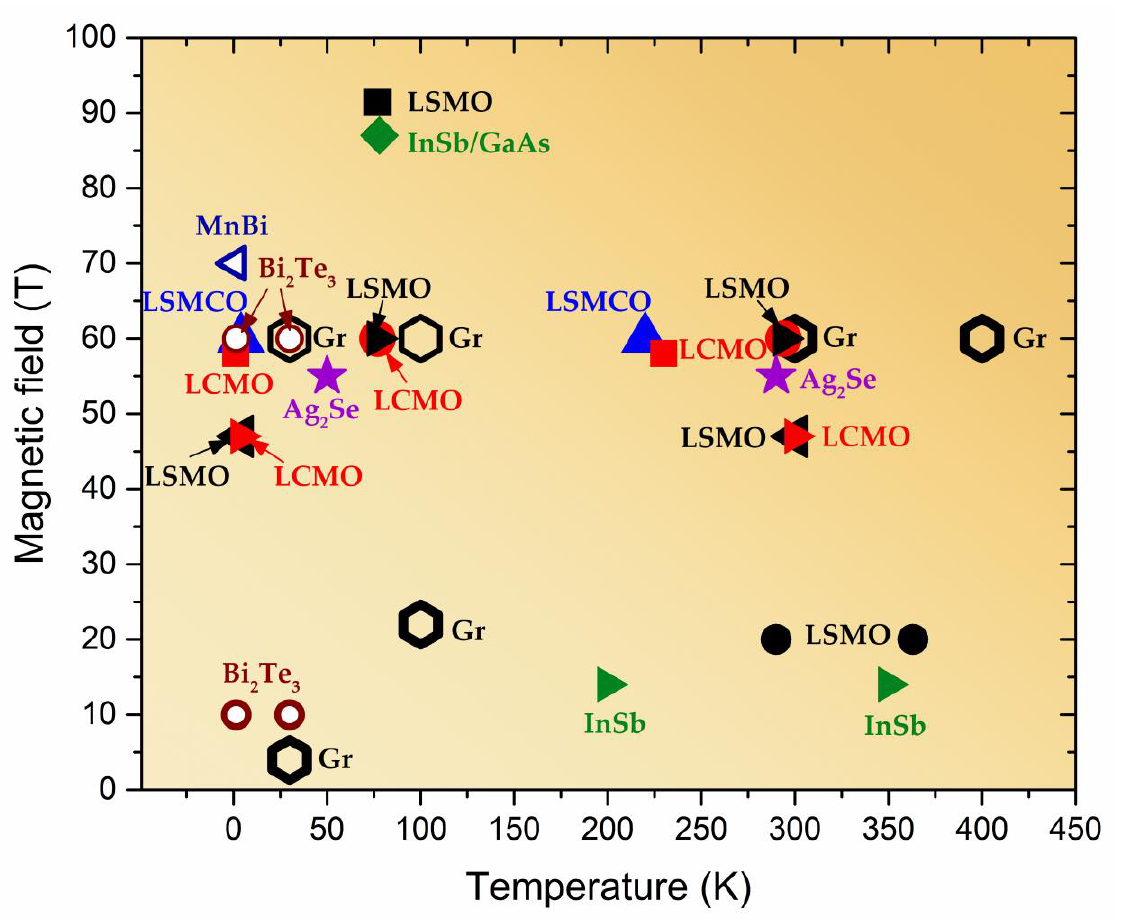
Figure 21. Overview of magnetic field and temperature ranges in which some classes of magnetic and non-magnetic magnetoresistive materials (discussed in this review) could be used for the development of high magnetic field sensors. Data are taken from different literature sources indicating magnetic fields and temperatures at which the magnetoresistance measurements were performed. LSMO, LCMO and LSMCO stand for manganites La-Sr-Mn-O and La-Ca-Mn-O and La-Sr-Mn-Co-O, respectively, Gr — graphene. The same symbol, but with thinner borders as shown for graphene and Bi 2 Te 3 , indicate that quantum oscillations superimposed on MR( B ) dependence were observed in high fields at low temperatures. The symbols correspond to the following references for LSMO: [127]; for Gr